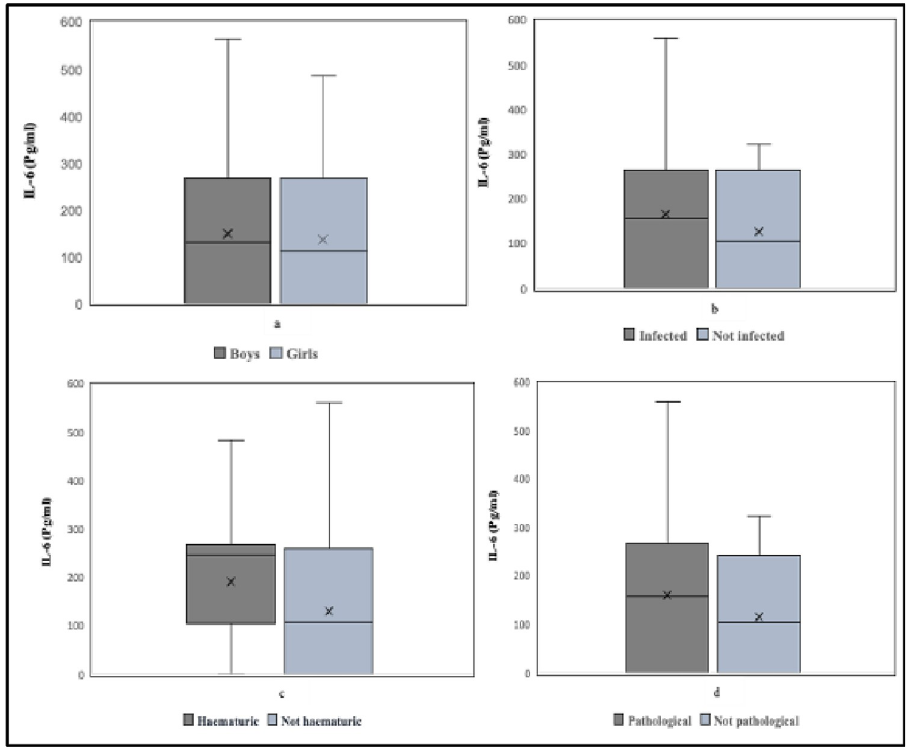
Fig 3. Box plot showing urinary IL-6 levels in relation to (a) sex, (b) S . haematobium infection, (c) haematuria and, (d) urinary bladder pathology. Solid line represents the median; X represents the mean and error bars represent the